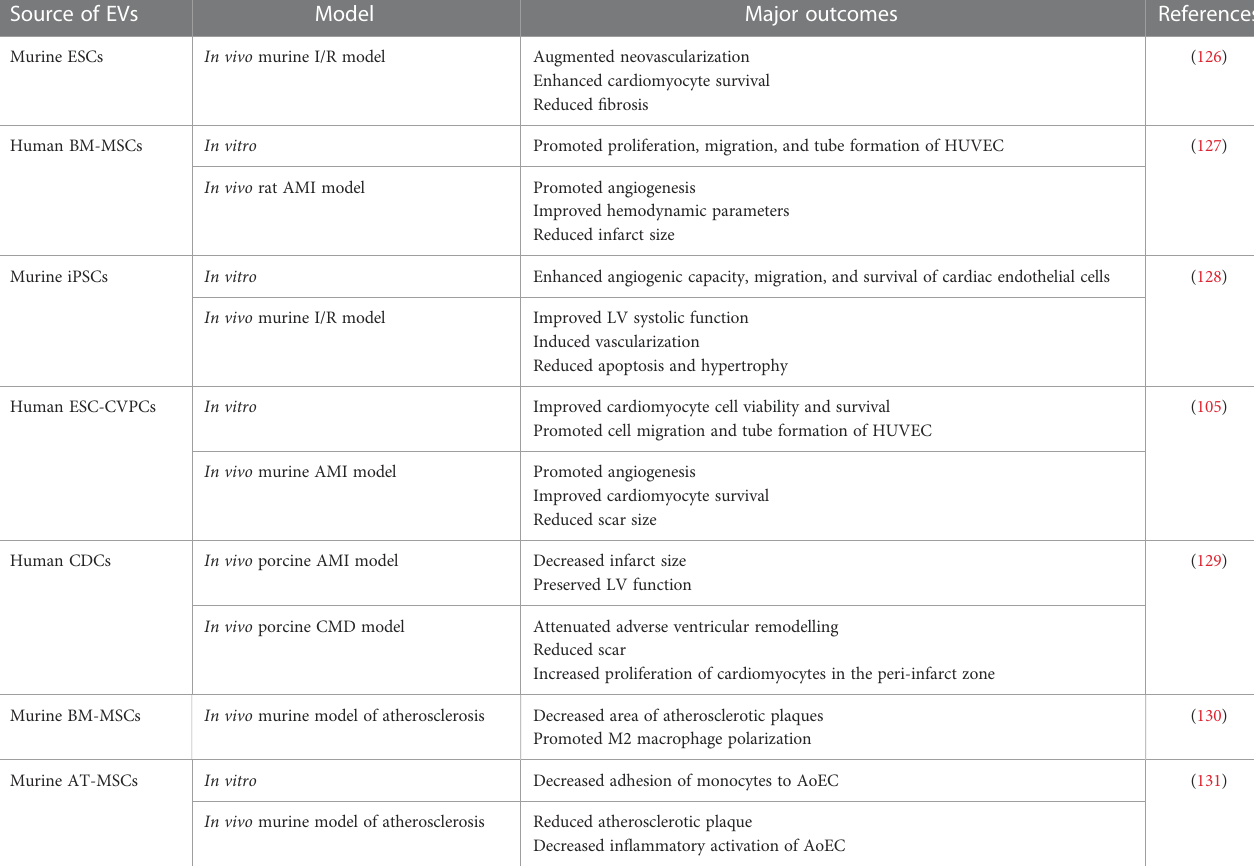
TABLE 1 Examples of EV use in preclinical studies related to CVDs